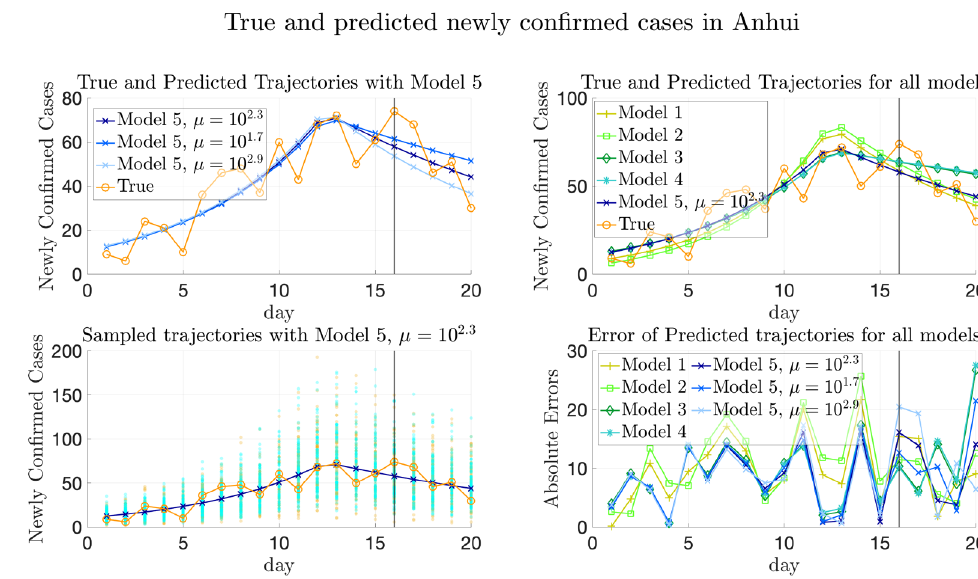
Figure 10. True and fitted trajectories in Anhui. The remarks for the lines and scatter plots are the same as those in Fig. 8. The choice of µ = 10 1.7 , 10 2.3 , and 10 2.9 has been explained in Fig. 9.